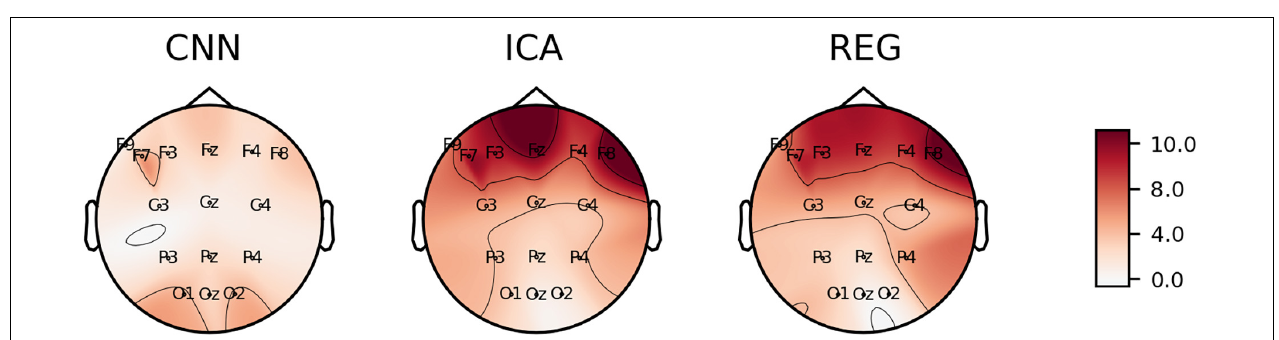
FIGURE 13 | The average value of RMSE coefficient plotted on the surface of the head.